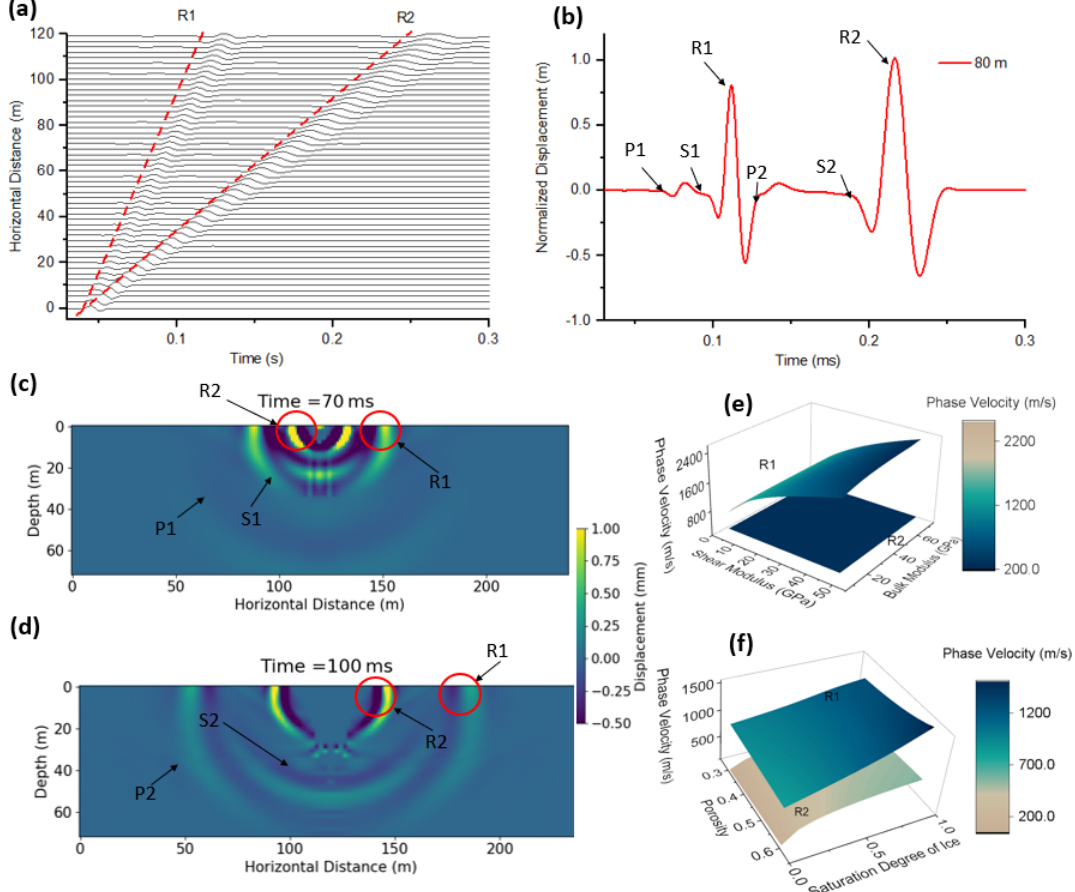
Figure 2. (a) Theoretical time-series measurements for R1 and R2 Rayleigh waves at the ground surface. (b) Waveforms of R1, R2, and other wave modes at the offset of 80m. (c) Displacement contour at time 70ms. (d) Displacement contour at time 100ms with the labeled R1 and R2 Rayleigh waves. (e) Effect of shear modulus and bulk modulus of the solid skeletal frame on phase velocity of R1 and R2 waves. (f) Effect of degree of saturation of ice on the phase velocity of R1 and R2